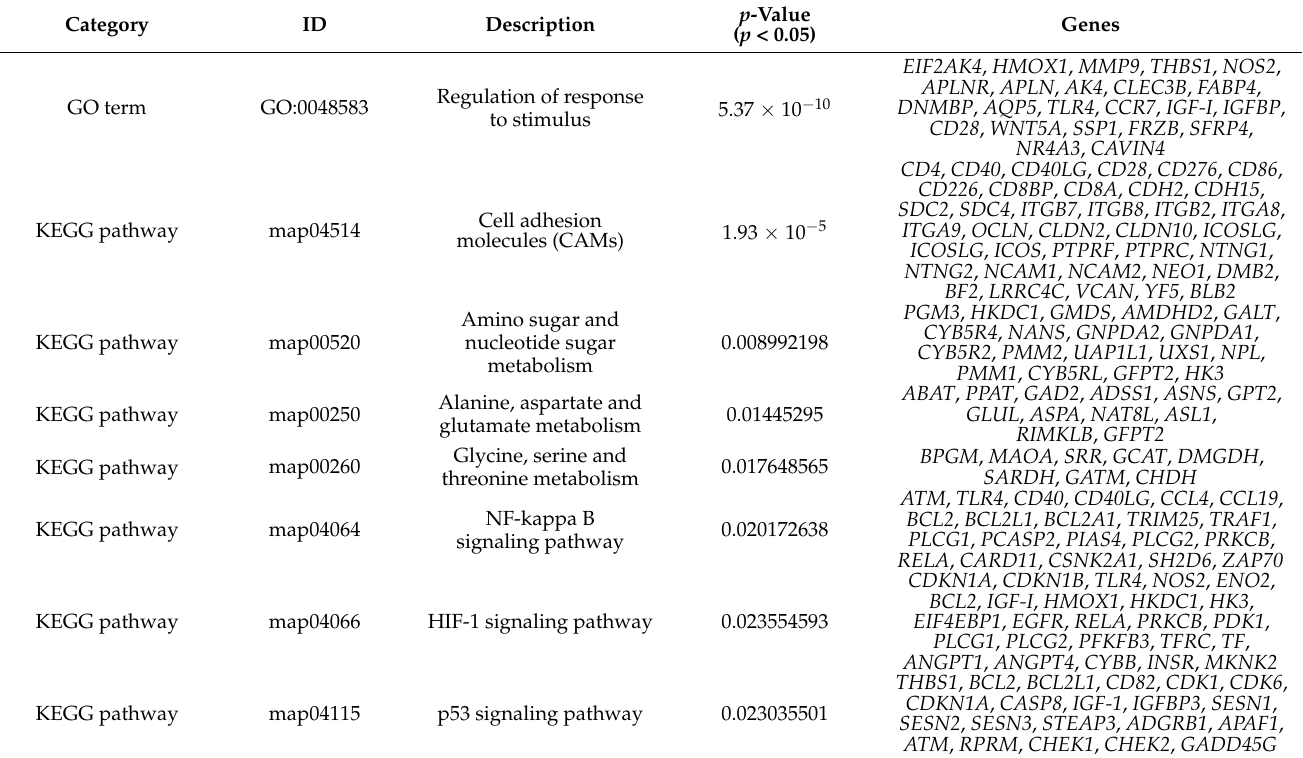
Figure 6. Up-regulated and down-regulated genes were obtained using KEGG enrichment analysis. The x -axis at the bottom indicates the number of genes corresponding to points on the broken line. The x -axis at the top indicates the significance of enrichment corresponding to the bar’s height.